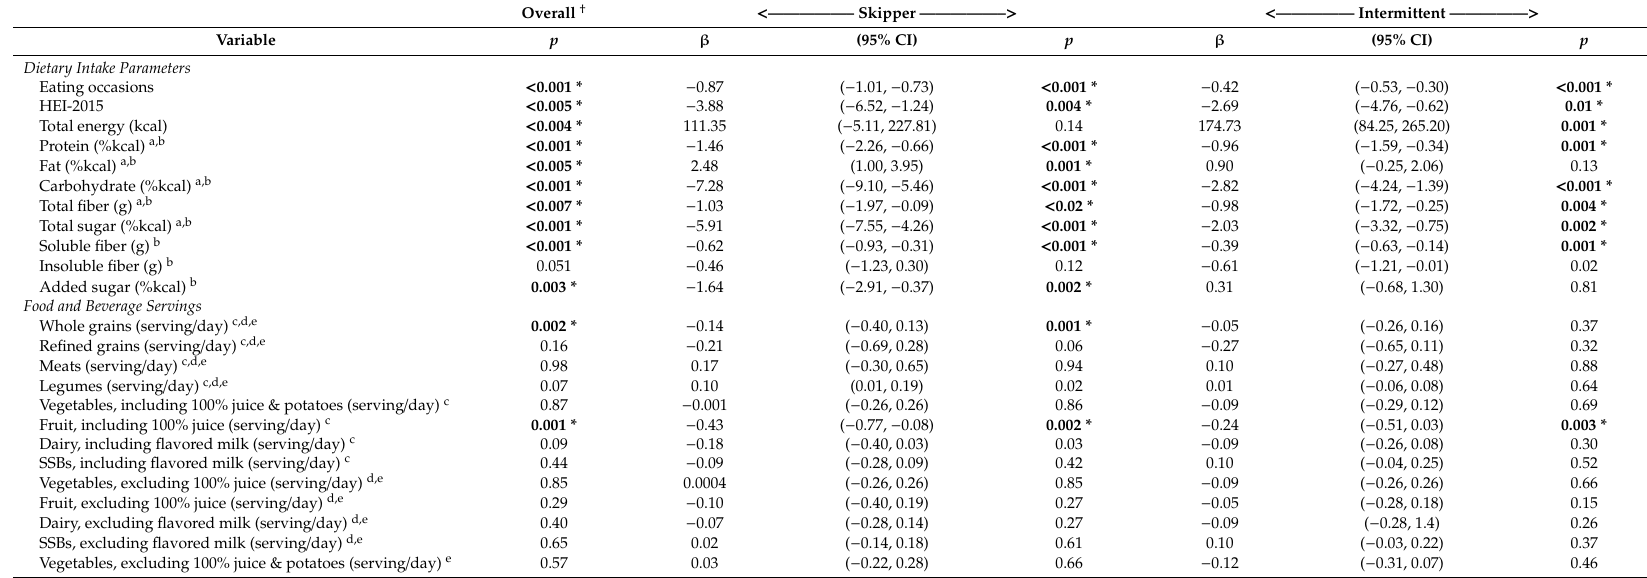
Table 4. Multivariate regression models of daily nutrient intake and daily food and beverage servings with regular consumers as the referent group ( n = 671). Overall † < —————– Skipper —————– > < ————— Intermittent ————— > Dietary Intake Parameters Eating